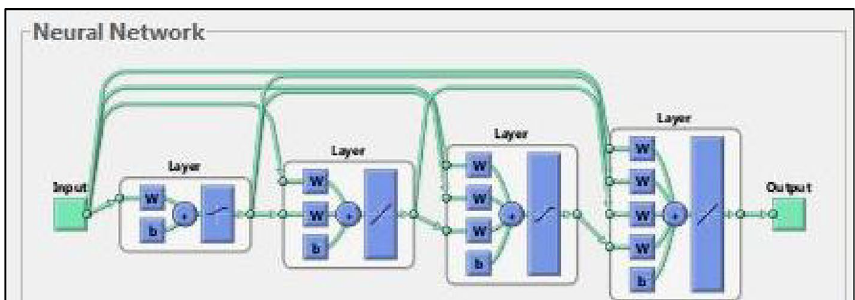
Fig. 5 ANN structure